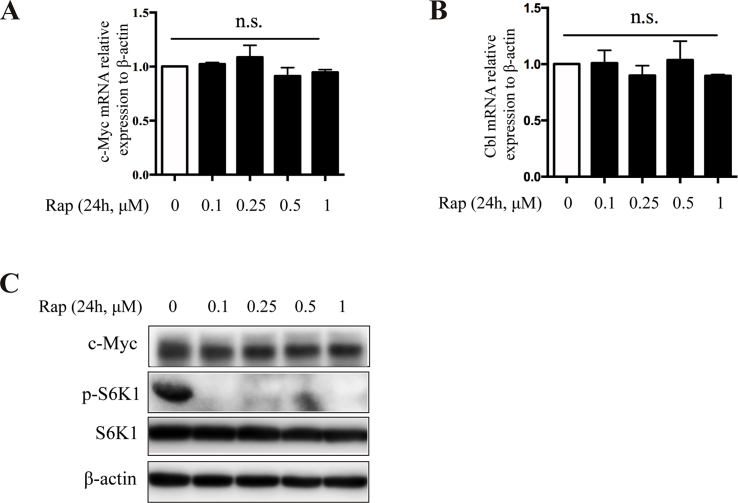
The impacts of rapamycin treatment on c-Myc and Cbl expression. A and B: SW480 cells treated with the indicated concentration of rapamycin for 24 h were subject to RT-PCR analysis for the mRNA expression of c-Myc (A) and Cbl (B), or were analyzed by immunoblotting for the protein expression of c-Myc (C).